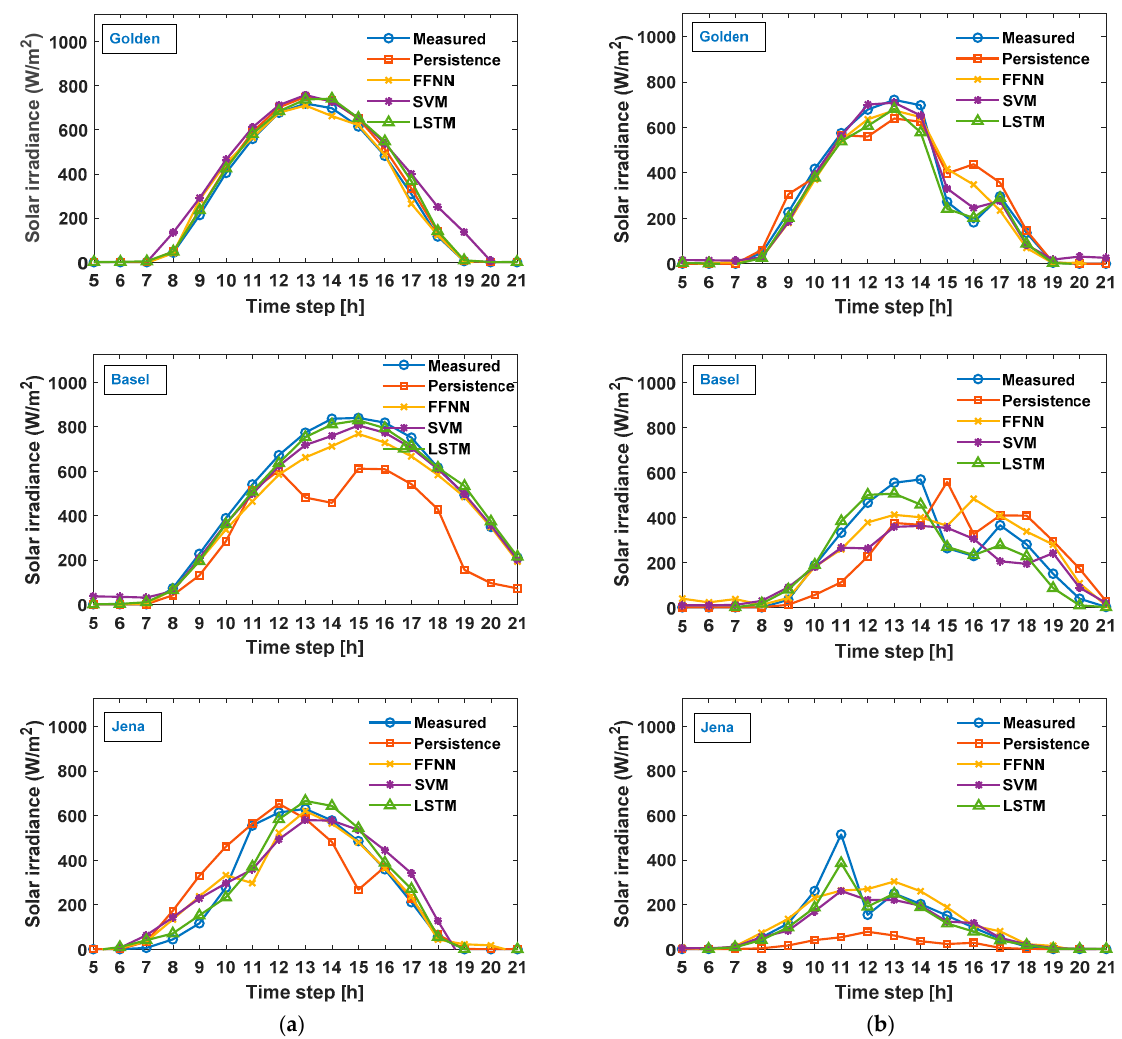
Figure 8. Graphical comparison of the measured and predicted SI values for ( a ) sunny and ( b ) cloudy days at (top to bottom) Golden, Basel, and Jena.